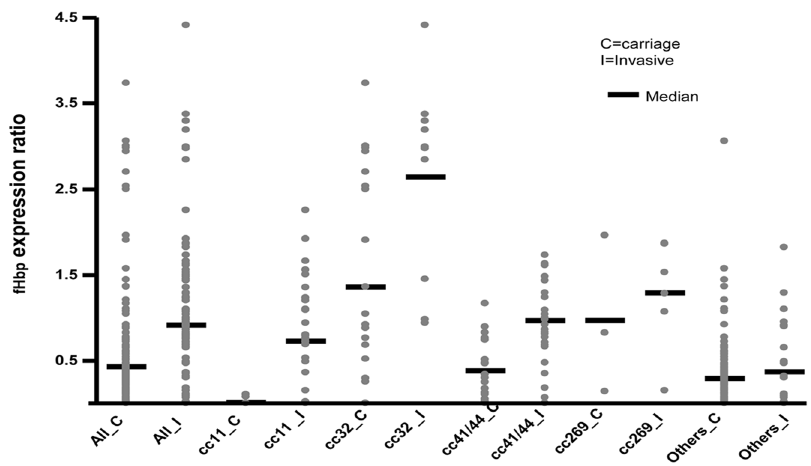
Figure 3. Distribution of relative levels of expression of fHbp among carriage and invasive isolates. Data were expressed as ratios of the expression for each strain compared to a reference strain a scatter plots (filled gray circles) and mean values (black lines). The clonal complexes (cc) to which belong the tested isolates are indicted under each group of scatter plots.